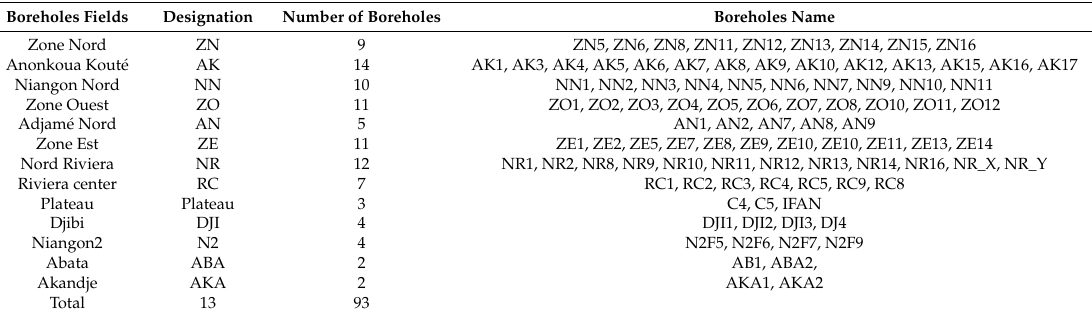
Table A1. Numbers and the names of the boreholes used in FEFLOW 7.1.